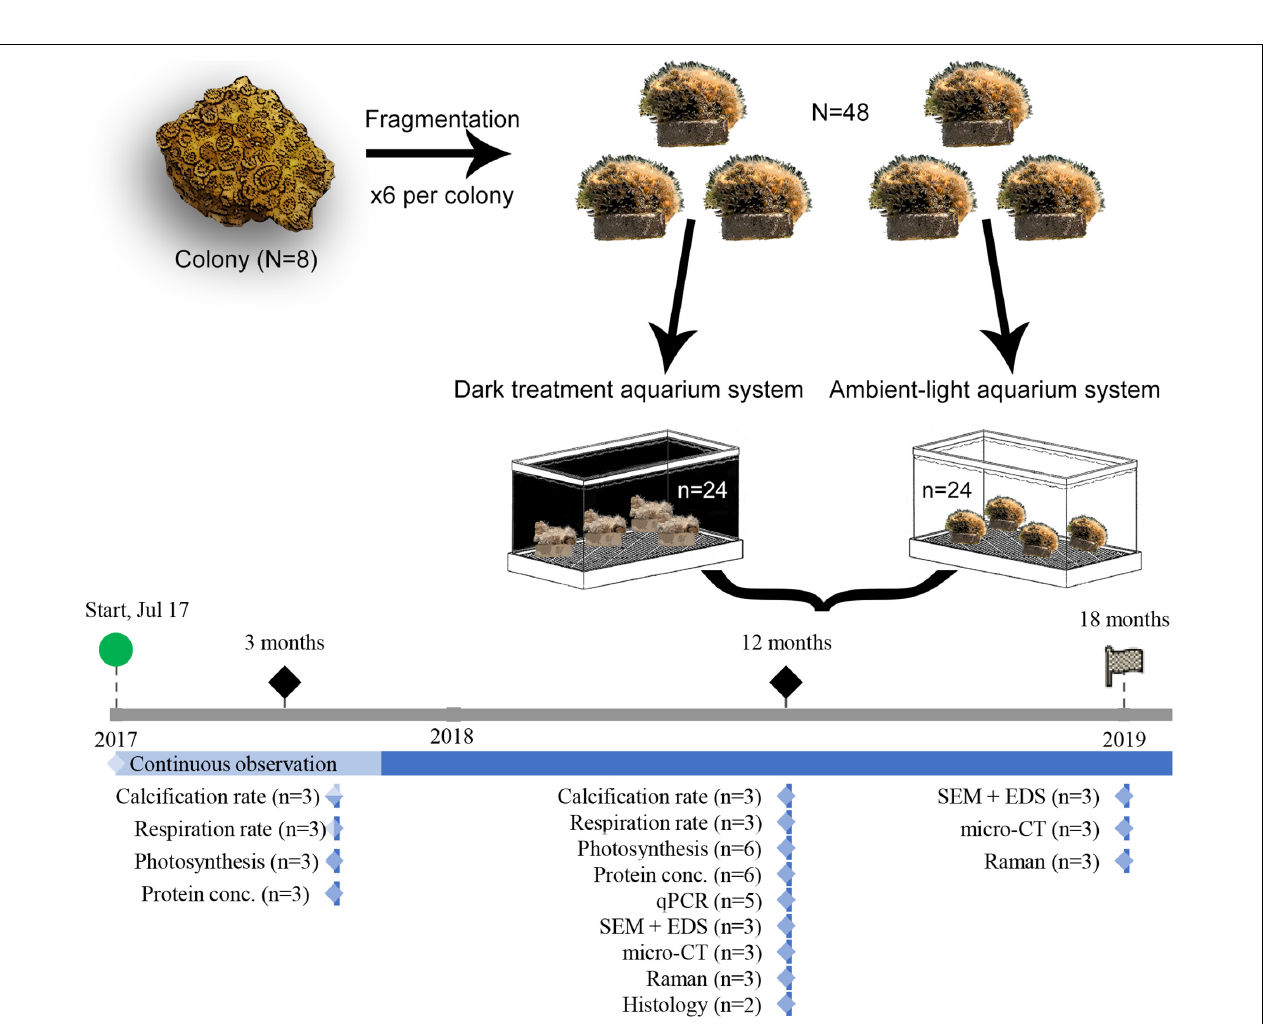
FIGURE 1 | Experiment setup and workflow. Graphic summary of the experiment procedures, from allocation of O. patagonica fragments and sampling strategy. The timeline depicts the collection and measurement